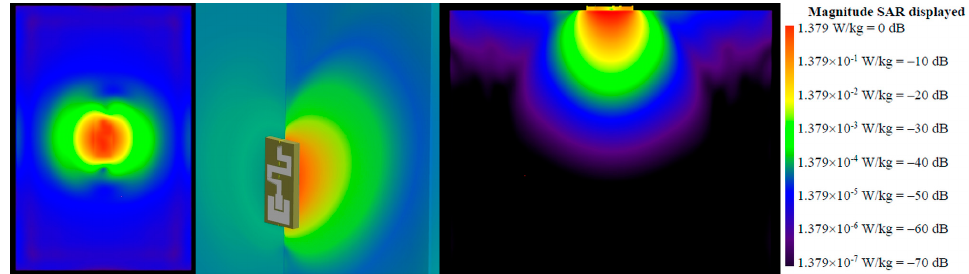
Figure 10. SAR distribution at 2.48 GHz.